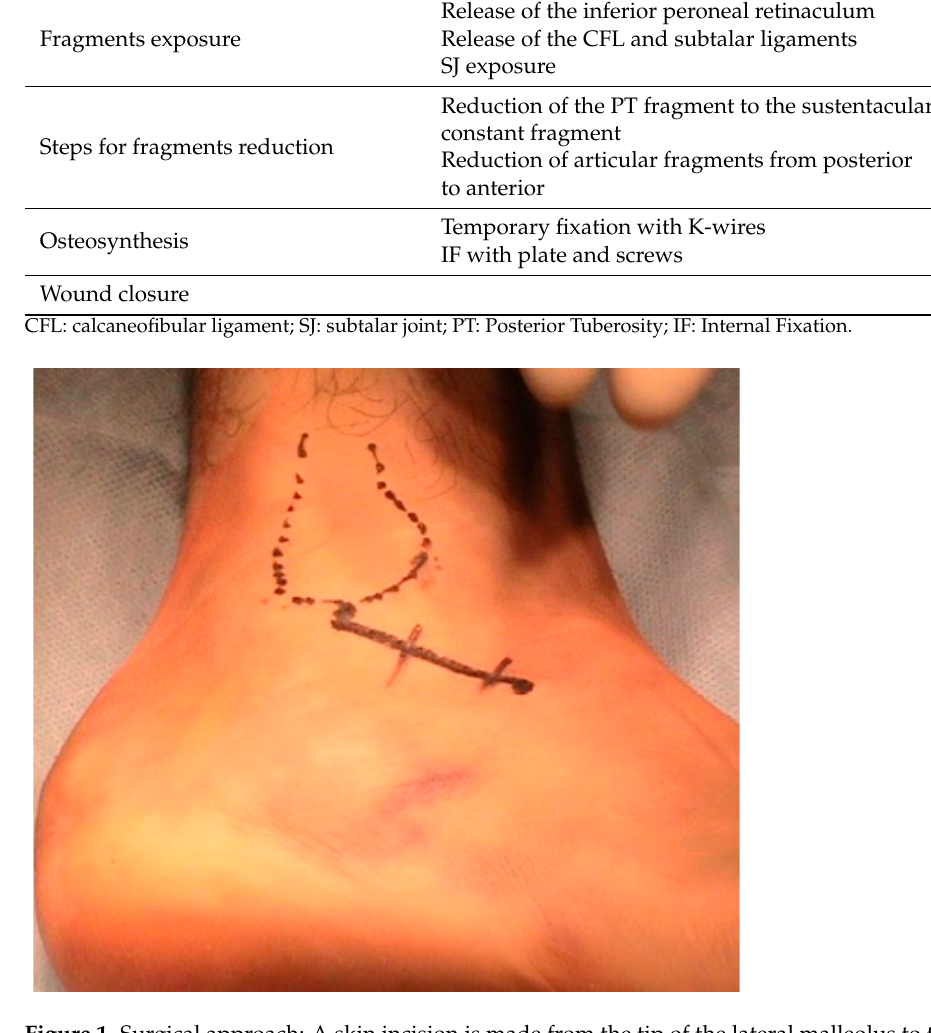
Table 2. Surgical procedure step-by-step.